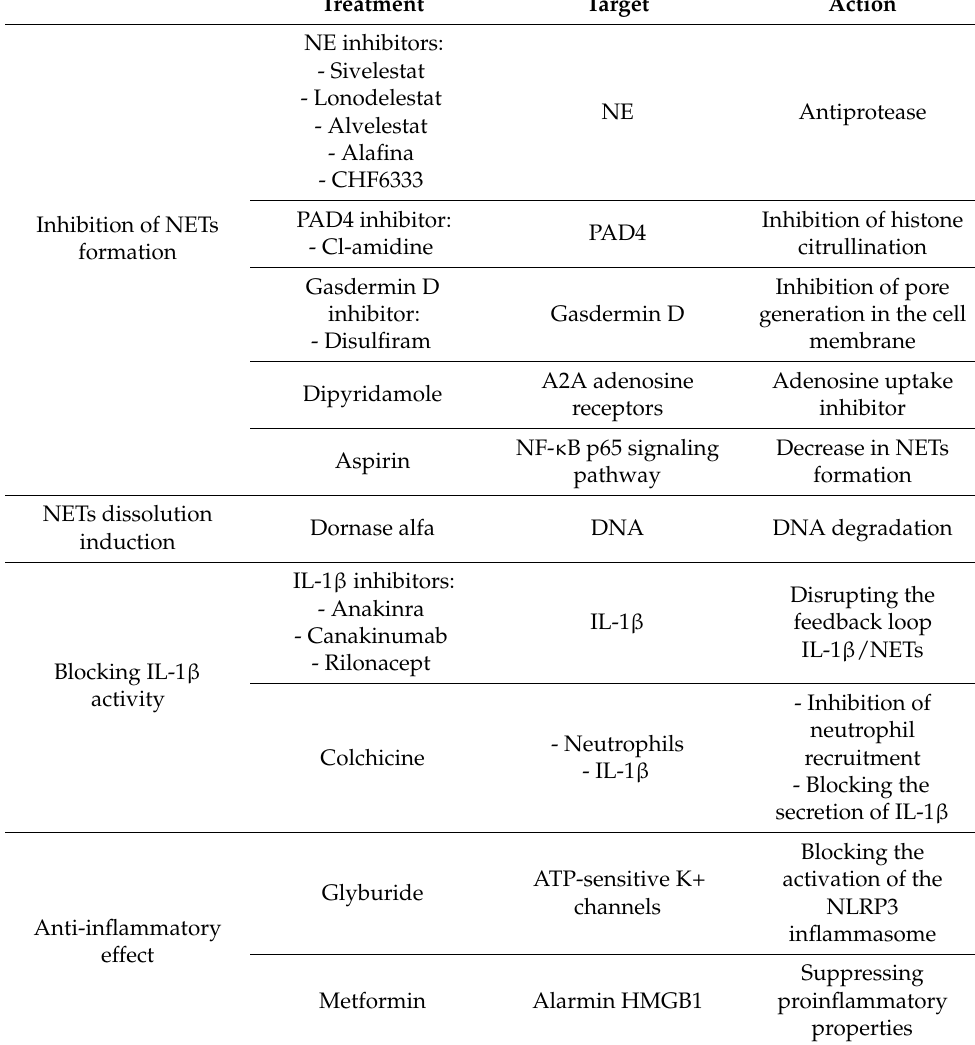
Table 1. Prospects of COVID-19 therapies based on extracellular neutrophil traps (NETs) blocking and anti-inflammatory